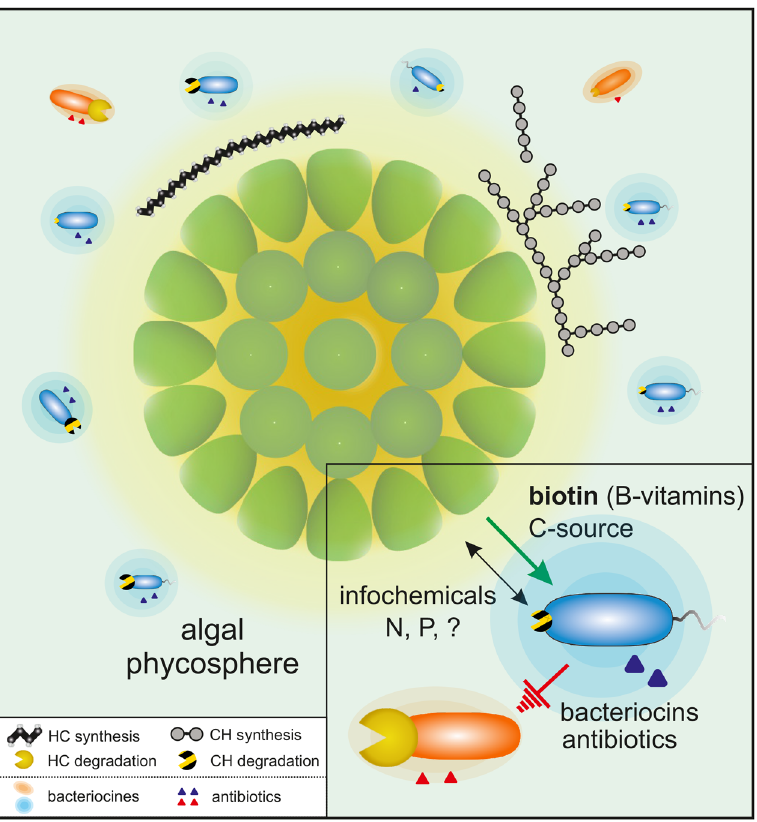
Figure 5. Alga-bacteria interactions within the Botryococcus braunii phycosphere. The depiction summarizes the observed generic potential encoded in the (meta)genomes of bacterial associates (Figs. 1 and 3), along with experimental validation within the minimal synthetic community (Figs. 2 and 4). The color code indicates the functional grouping of the community members: supportive B-vitamin-auxotrophic (blue) and hydrocarbonoclastic prototrophic (red). The potential for degradation of hydrocarbons and carbohydrates of the bacterial associates is illustrated via yellow and striped pacmans, respectively. The genetic predisposition to the synthesis of bacteriocins and antibiotics encoded by the secondary metabolite biosynthesis gene clusters, is indicated by the halos and triangles, respectively. Abbreviation: HC, Hydrocarbons; CH, carbohydrates; B 7 , Biotin; N, nitrogen; P,